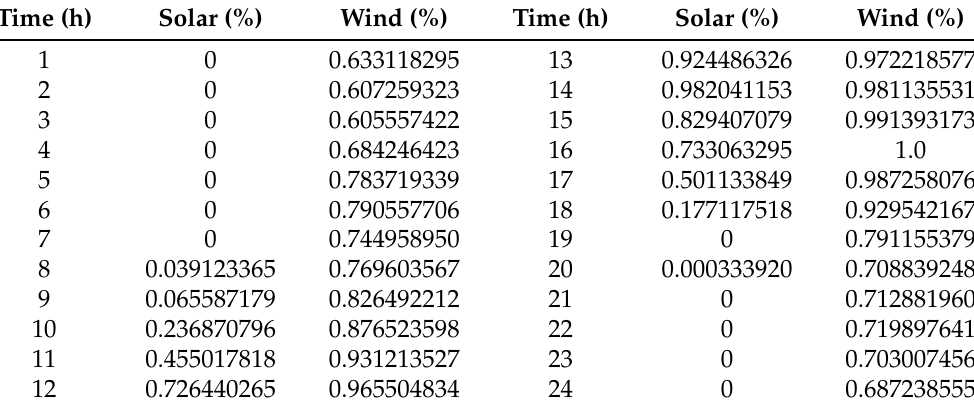
Table 27. Renewable